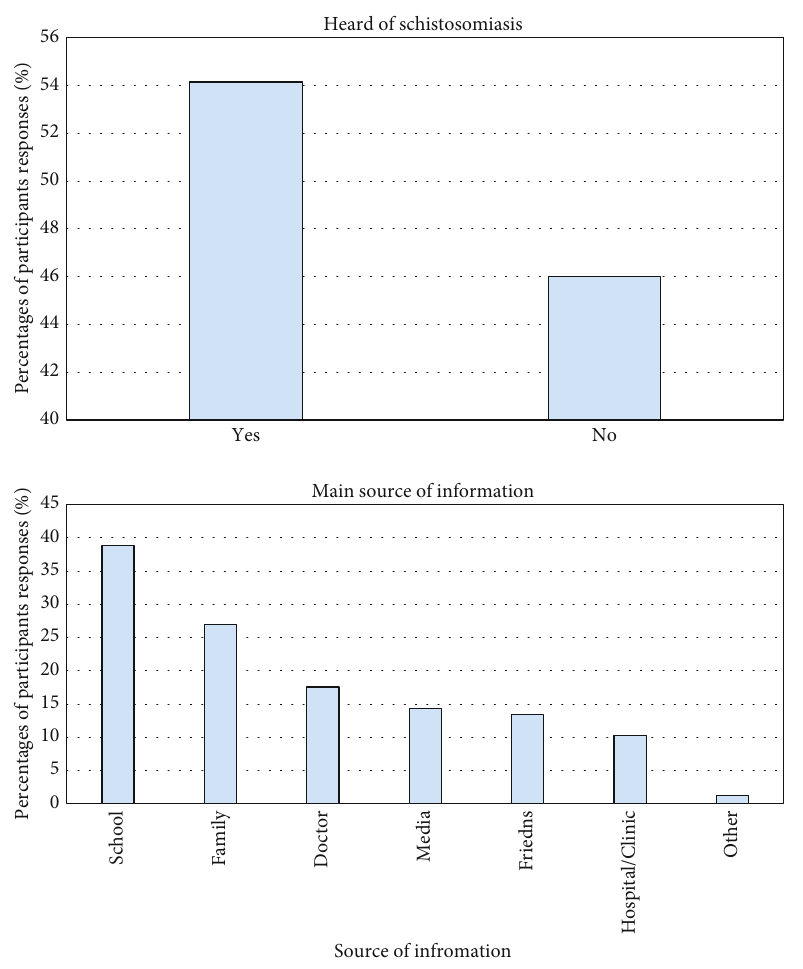
Figure 4: Study participants ’ awareness of schistosomiasis and main source of information.